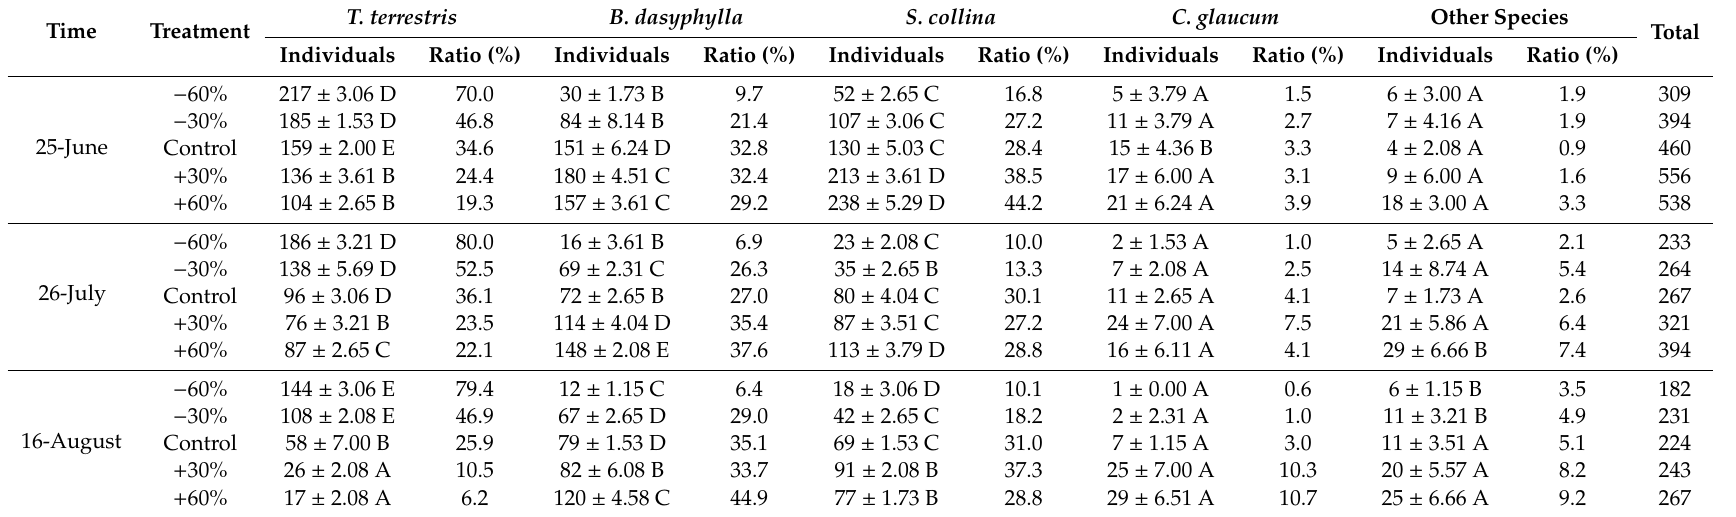
Table 1. Influence of di ff erent precipitation treatments on plant